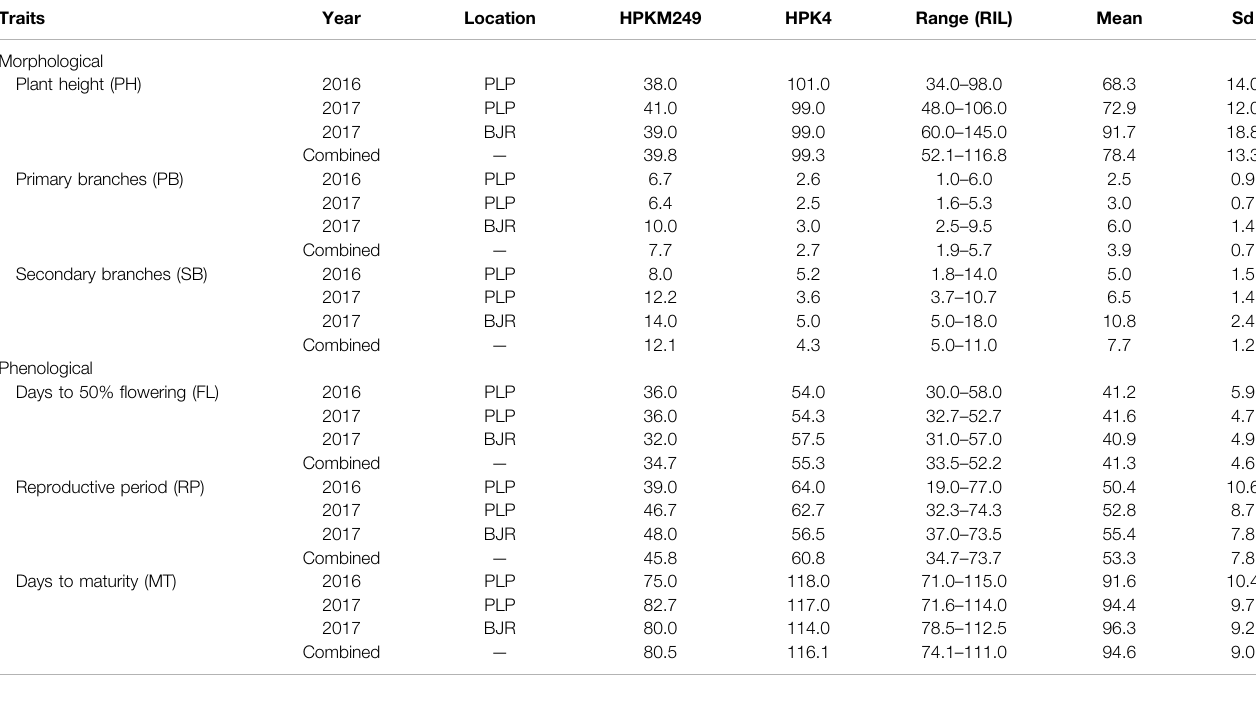
TABLE 2 | Mean performance of parents and RILs for phenological and morphological traits. Traits Morphological Plant height (PH)